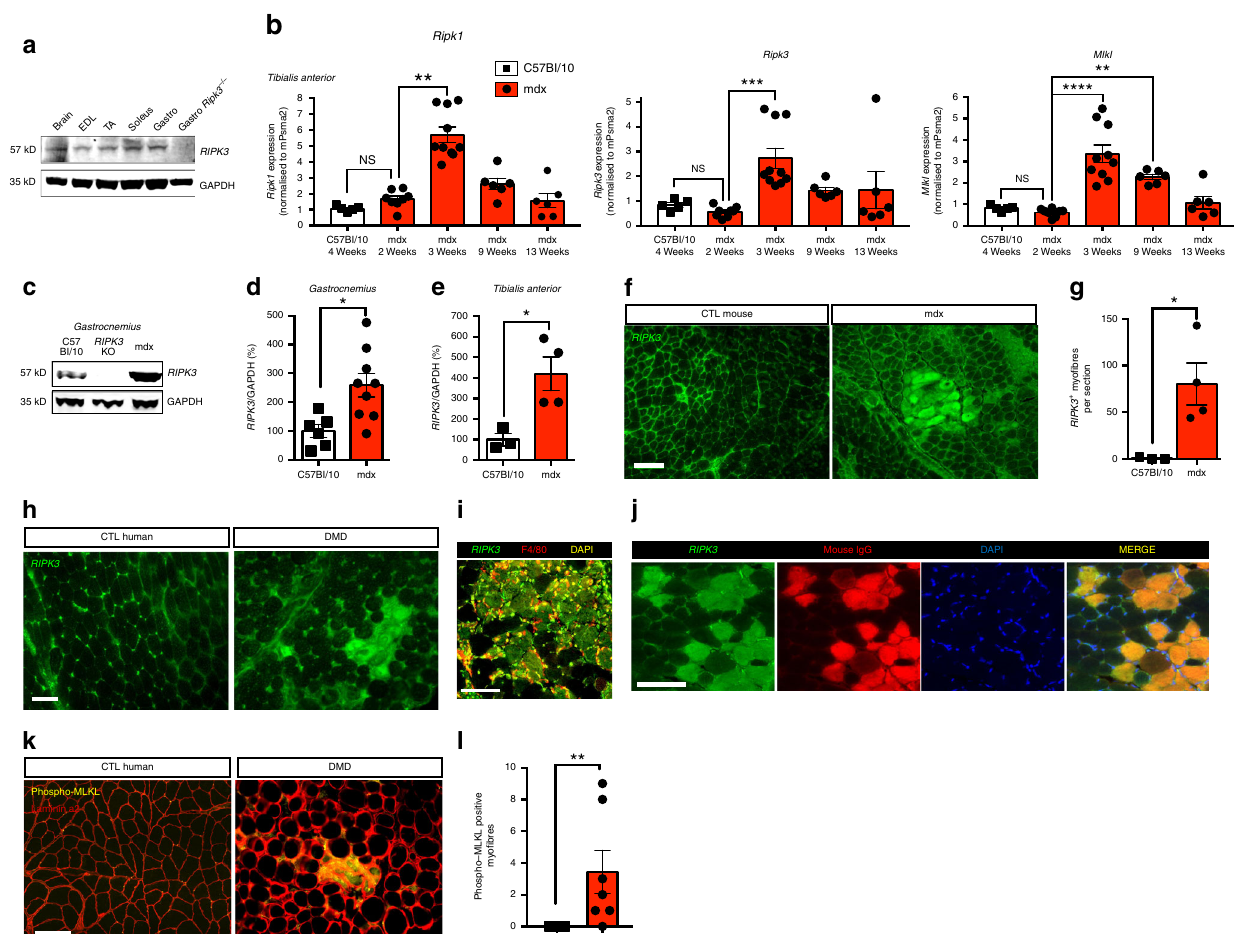
Fig. 1 Necroptosis is activated in mouse and human dystrophin-de fi cient muscles. a Immunoblot of RIPK3 protein expression in brain, extensor digitorum longus (EDL), tibialis anterior (TA), soleus , and gastrocnemius muscles of C57BL/6 and gastrocnemius from RIPK3 KO mouse. GAPDH was used as loading control. b Tibialis anterior muscles of 4-week-old C57BL/10, and 2-, 3-, 9-, and 13-week-old mdx mice were analysed for Ripk1 , Ripk3 , and Mlkl mRNA levels by quantitative PCR. Data were normalised to mouse Psma2 gene expression ( n = 5 C57BL/10 and n = 5, 8, 10, 6, and 6 respectively, for 2-, 3-, 9-, and 13- week mdx TAs, Dunn ’ s multiple comparison test). c Protein extracts of C57BL/10, RIPK3 KO, and mdx gastrocnemius muscles were analysed by western blot for RIPK3 and GAPDH protein expression. Quanti fi cation of RIPK3 protein expression normalised to GAPDH in gastrocnemius ( d ) and TA ( e ) ( n =